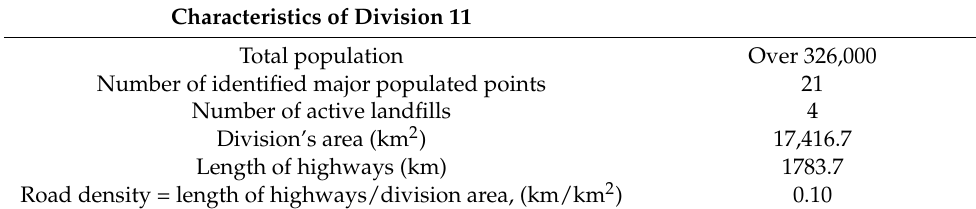
Table 1. Details of the study area.